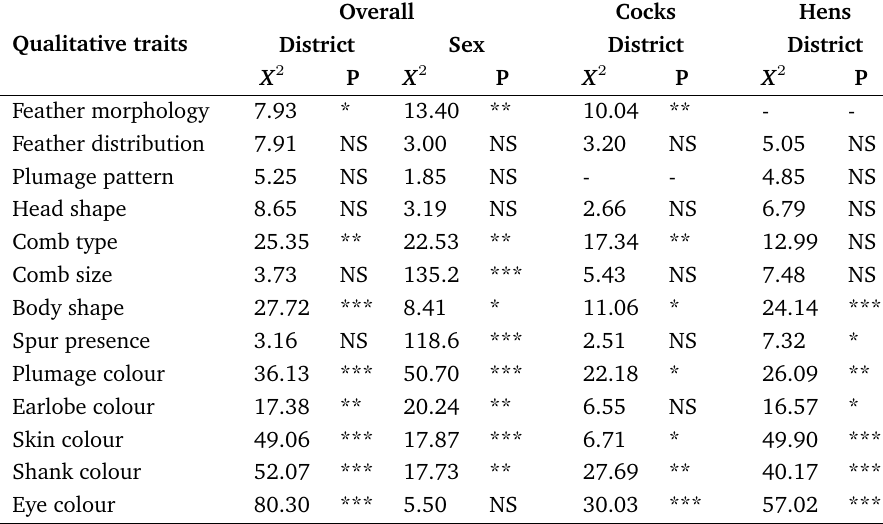
Table 5. Chi-square values and probabilities for the effect of classes on qualitative characteristics for the overall analysis and separately for both sexes. X 2 = chi-square value; P = probabilities; *p < 0.05, **p < 0.01, ***p < 0.0001, NS = Not Significant.